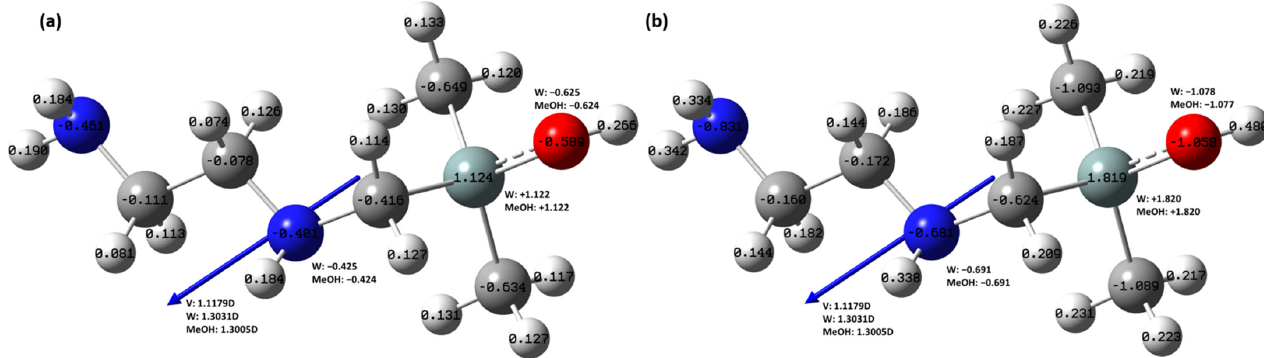
Figure 7. Partial charges for silanol: ( a ) Mulliken, ( b ) NPA from NBO; implicit solvents: W—water, MeOH—methanol, V—vacuum.